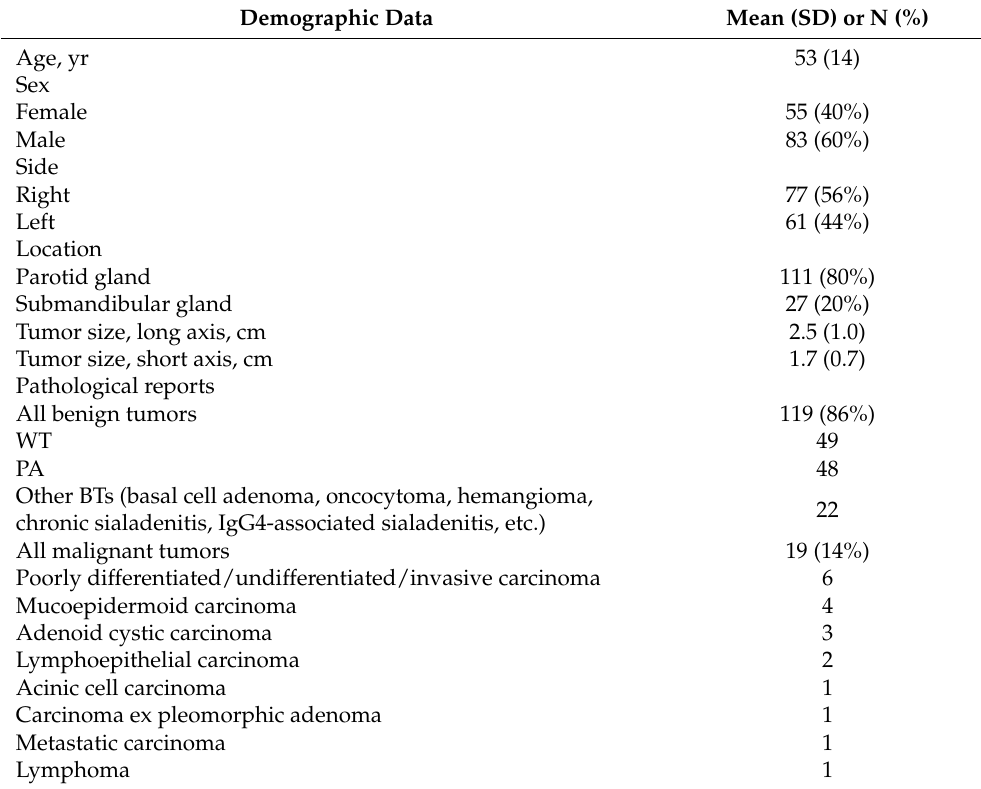
Table 1. Clinical characteristics of the included cases (N =